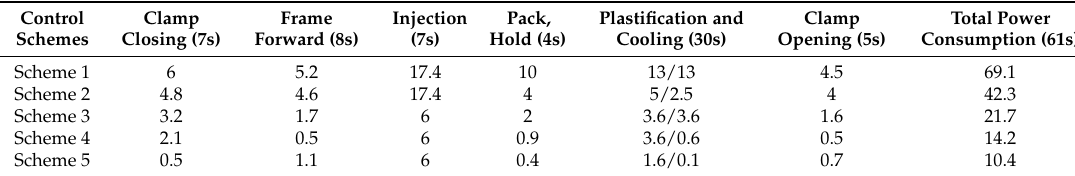
Table 1. Power consumptions of an IMM with five different control schemes (kW).